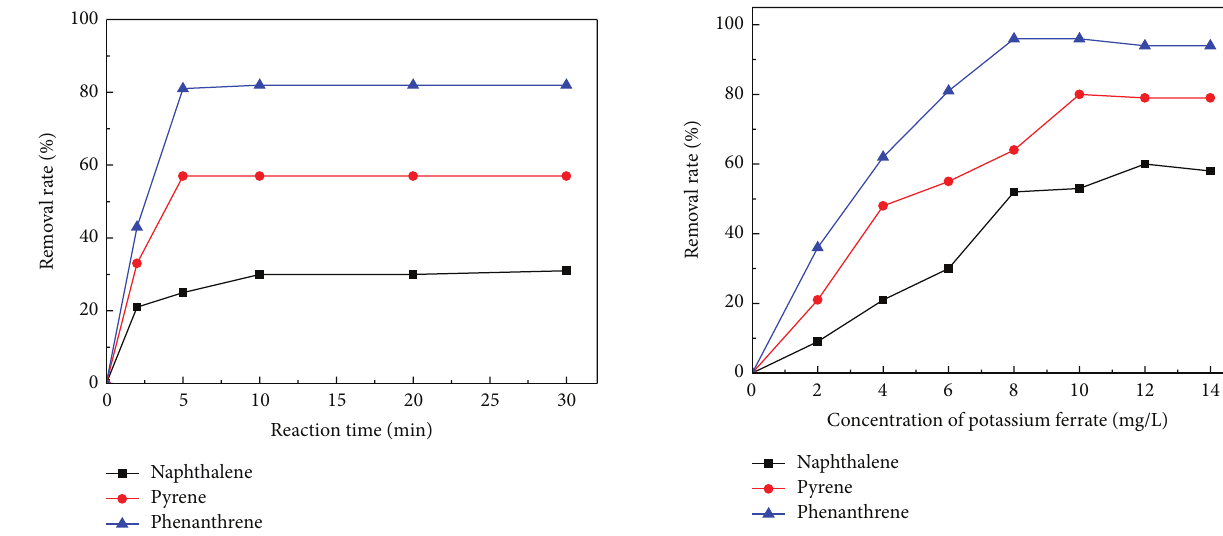
Figure 3: Influence of reaction time on aromatic hydrocarbons conversion and removal.